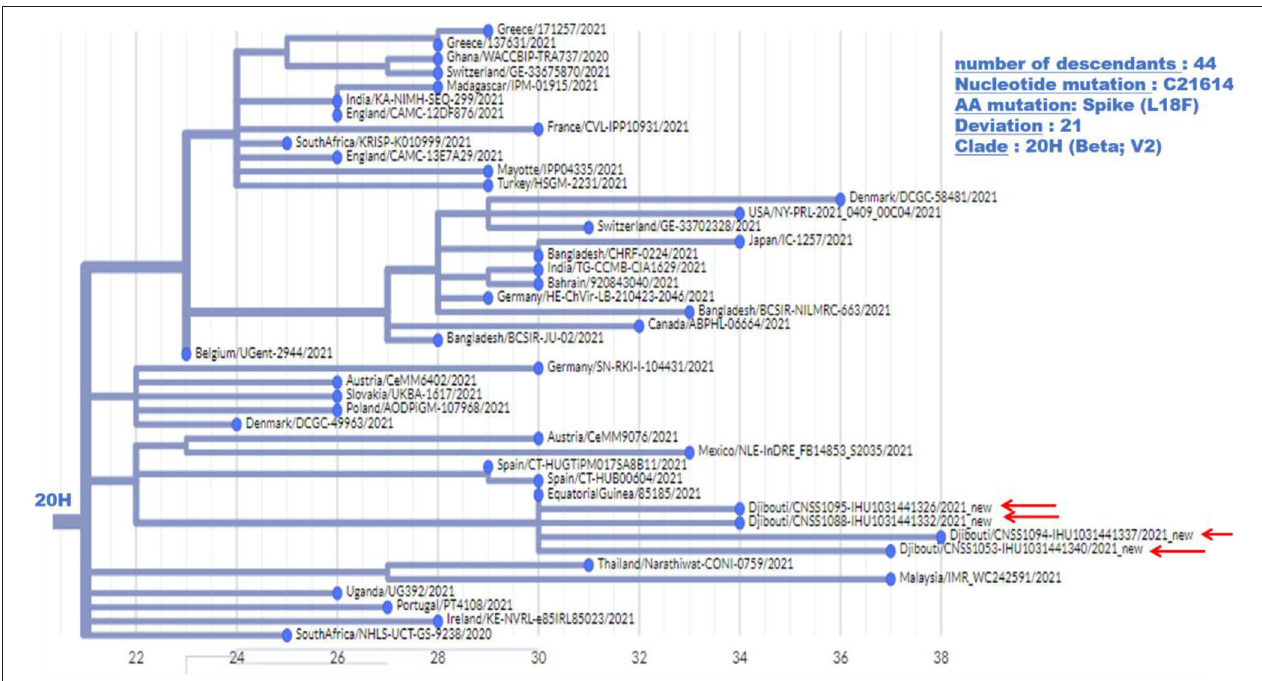
FIGURE 6 | Phylogenetic tree (obtained using the Nexcladevv0.14.4 software (https://clades.nextstrain.org/), including four South African variants of SARS-CoV-2 strains from the second COVID-19 wave in Djibouti compared to forty SARS-CoV-2 sequences (clade 20H) available through GISAID and automatically selected using Nextclade. The scale at the bottom of the figure indicates the number of mutations (deviation) compared to the sequence of the reference strain (Wuhan-Hu-1 reference strain; GenBank accession no. NC_045512.2).